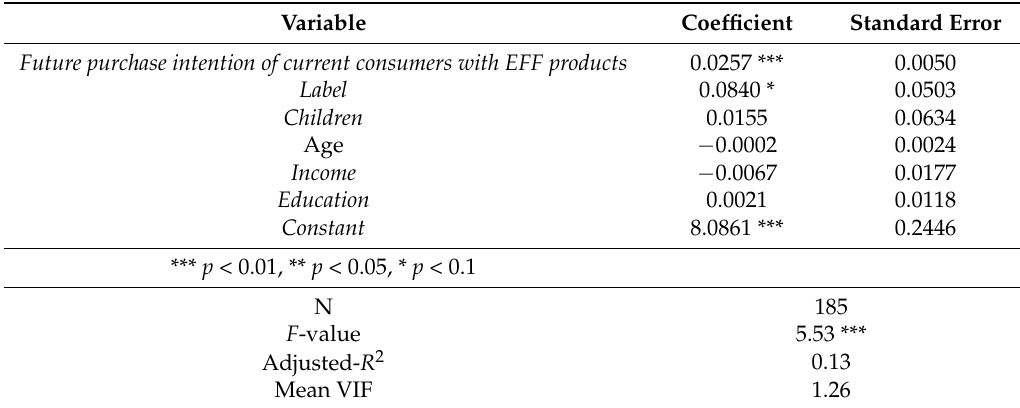
Table 3. Coefficient estimates and standard errors of ordinary least squares (OLS) regression.